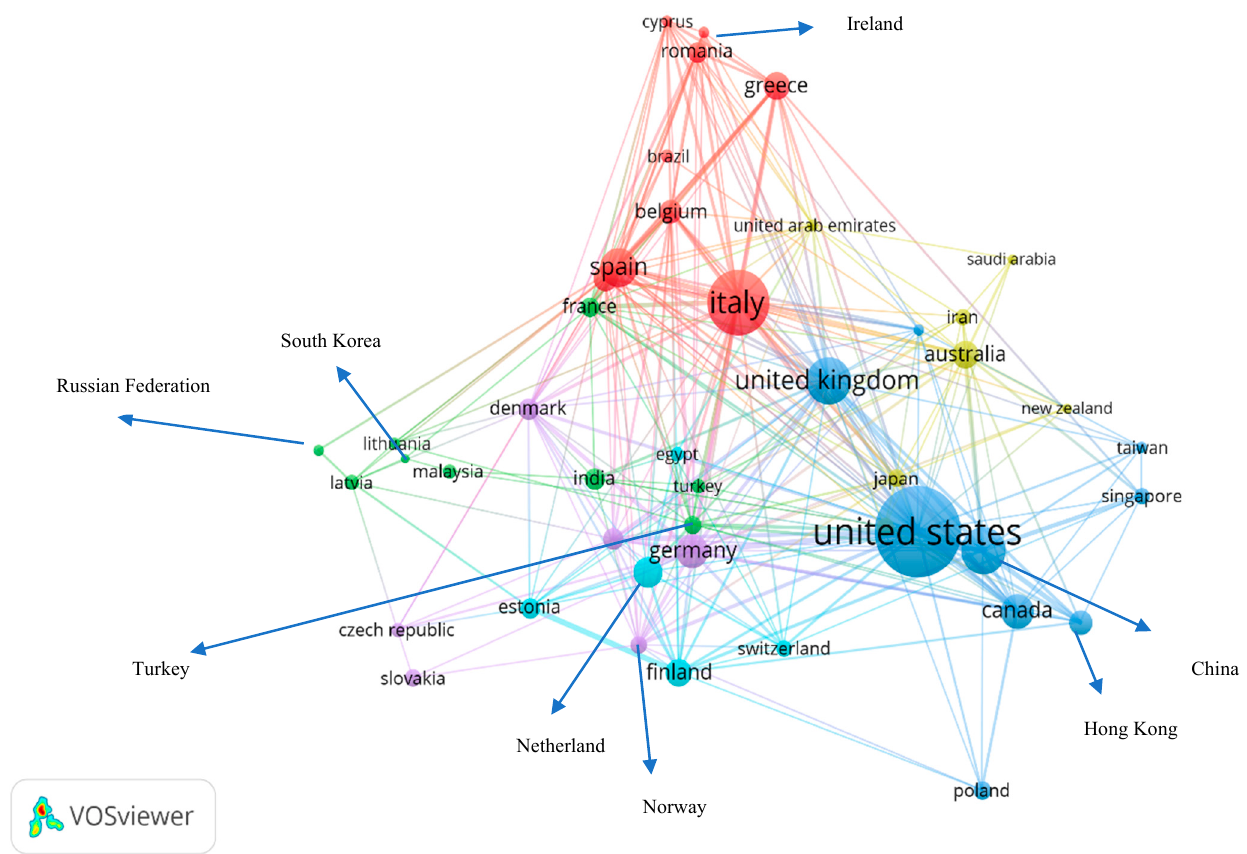
Figure 4. Geospatial distribution of research publications.